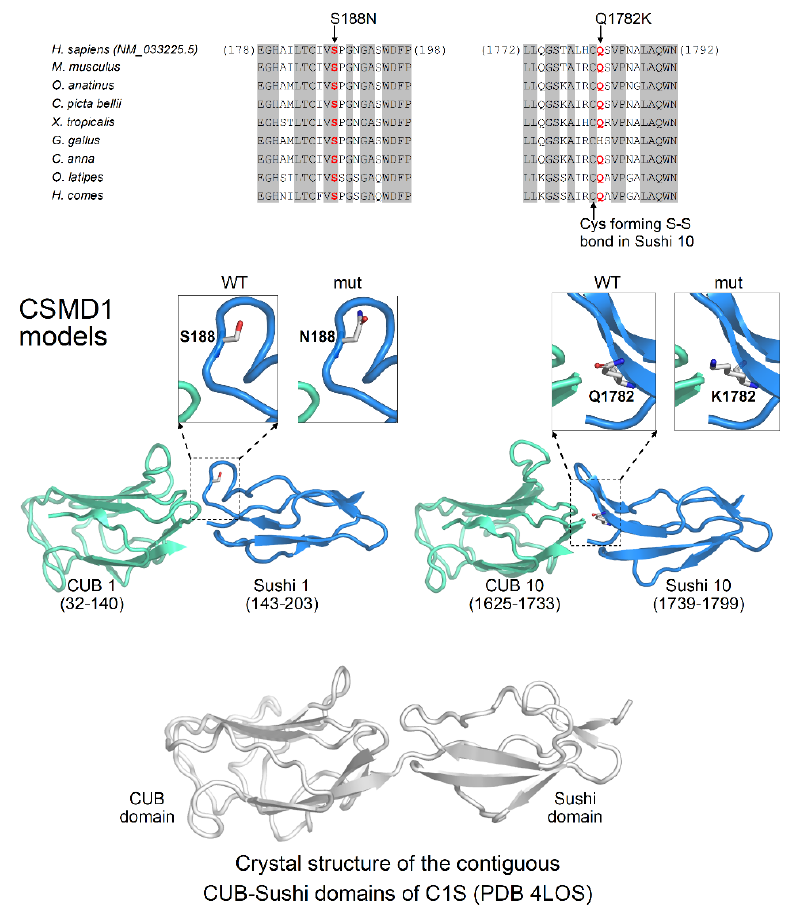
Figure 3. Homology Modeling of the CSMD1 variants. Top: multiple sequence alignment of CSMD1 protein among organisms around the sites of p.Ser188Asn and Gln1782Lys mutations. Invariant columns are grayed. Bottom: molecular models of the Sushi domains (blue ribbons) involved by mu- tations. The CUB domains (green ribbons) immediately N-terminal are also modeled, and both Sushi and CUB domains are mutually positioned as in the PDB structure 4LOS (white ribbons), representing the crystal structure of the contiguous CUB/Sushi domains of complement C1s